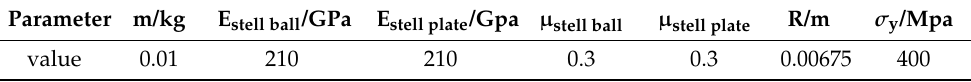
Table 1. Calculation parameters.